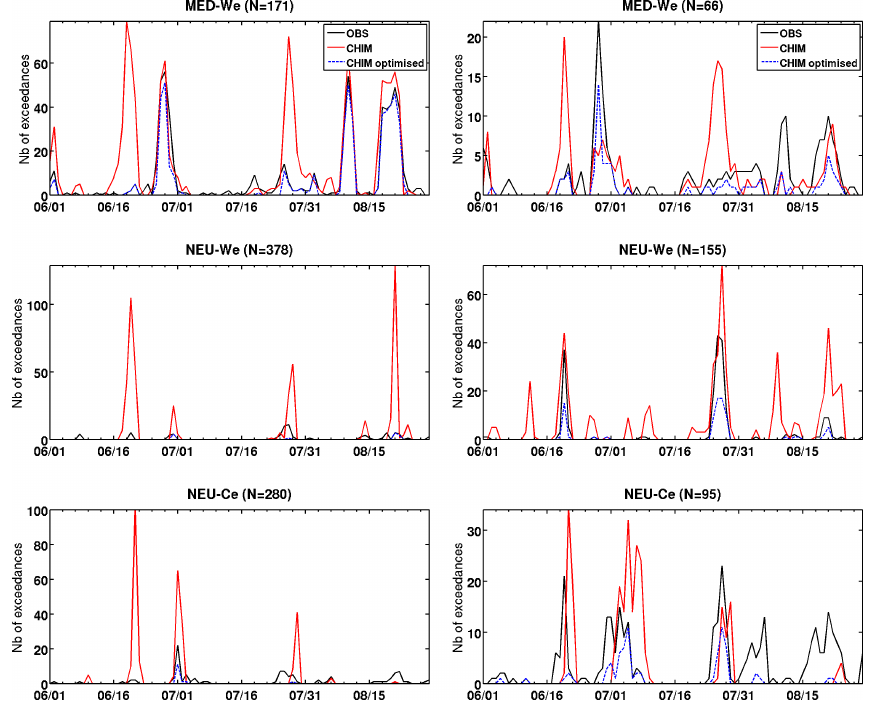
Figure 13. Number of stations in daily exceedances of the European Union air quality threshold of 50µgm − 3 for daily mean PM 10 con- centrations (left panel), and in daily exceedances of the WHO recommendation of 25µgm − 3 for PM 2 . 5 concentrations (right panel). This time series is computed during the summer of 2012 (1 June to 31 August 2012), as observed at the rural and background stations (black line) and simulated by the CHIMERE model at the same locations (red line). The dashed blue line is the number of exceedances when the bias is removed for each point, as described in Sect.